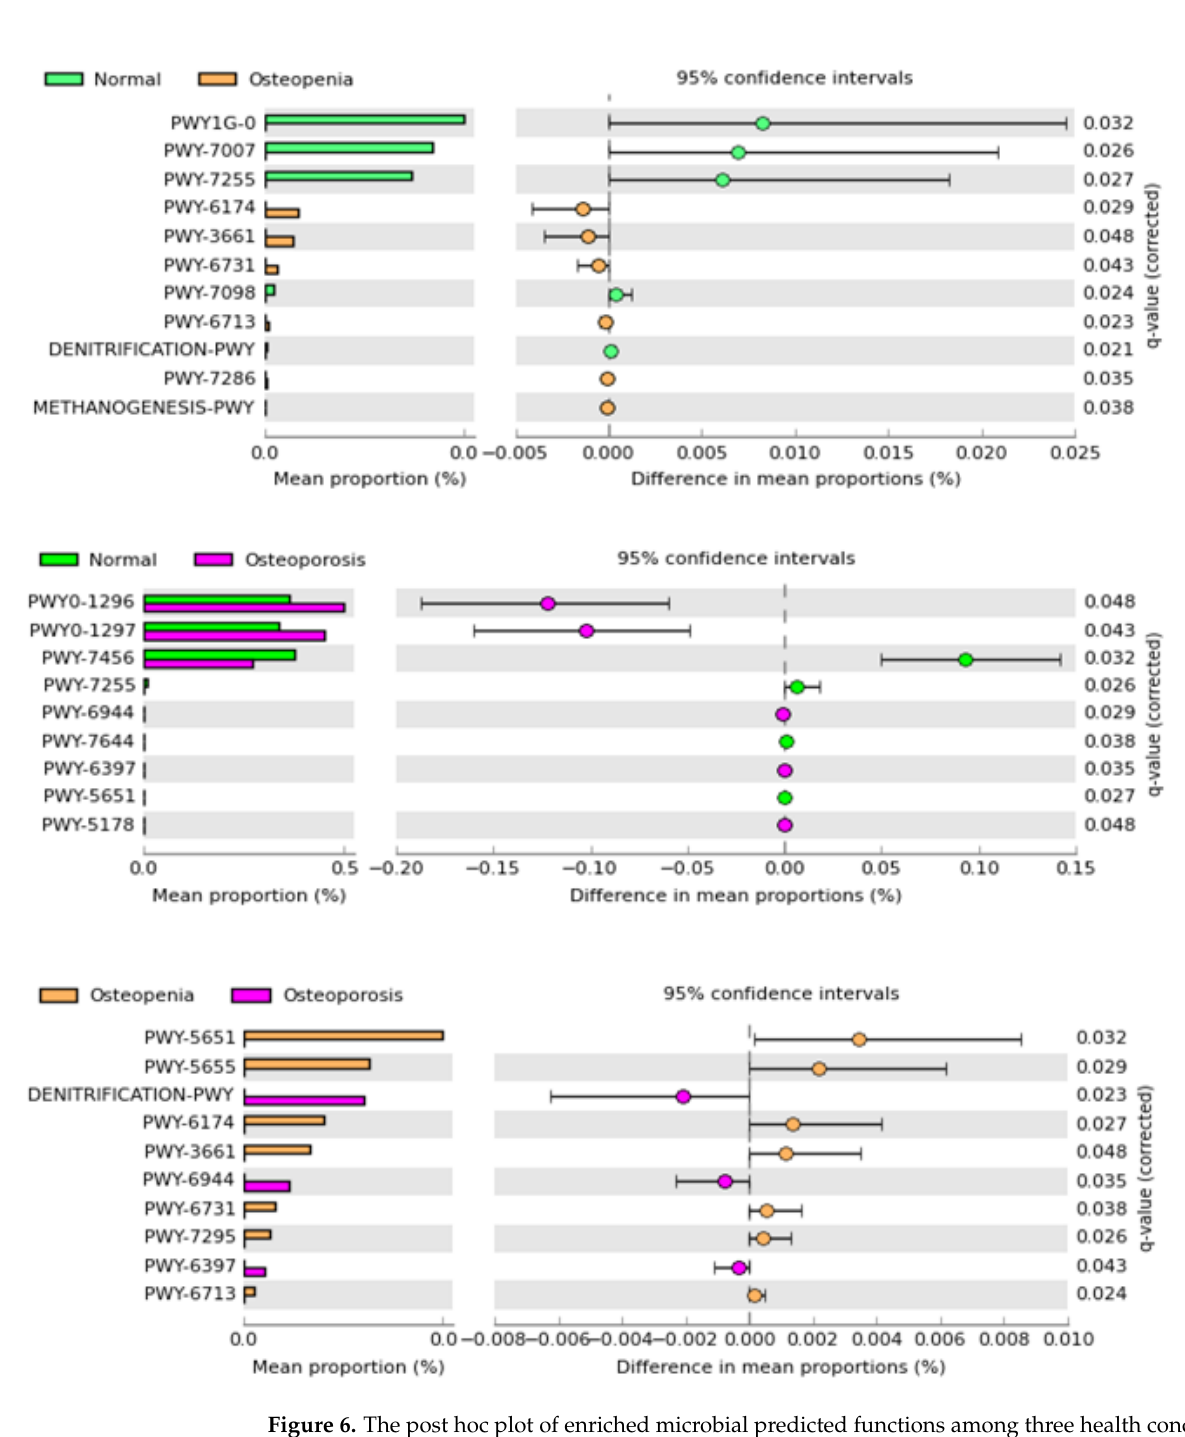
Figure 6. The post hoc plot of enriched microbial predicted functions among three health conditions (healthy, polyps, and cancer). The left panel of these figures shows the abundance ratio of differentially enriched KEGG pathways. The right panel represents the significant difference at p < 0.05, whereas the middle one indicates the mean proportion of differentially enriched KEGG pathways in the 95%